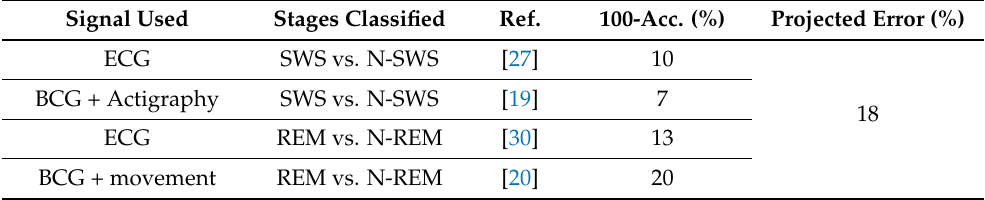
Table 6. State-of-the-art macro-labeling performance with respect to projected performance based on the HBI error